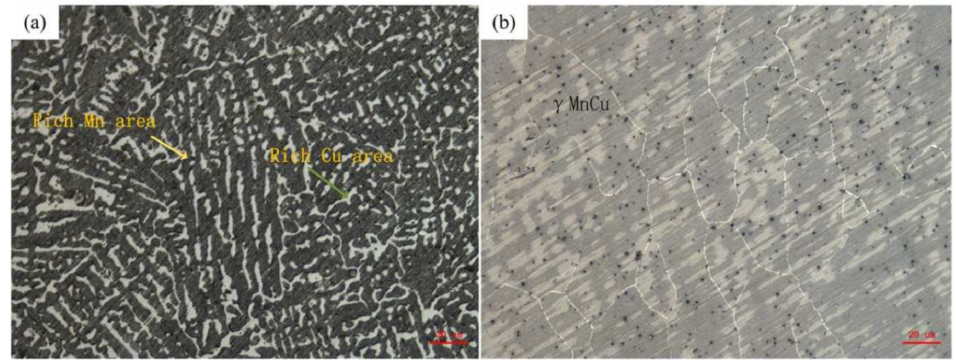
Figure 3. Microstructures of M2052 ( a ) as-deposited and ( b ) after